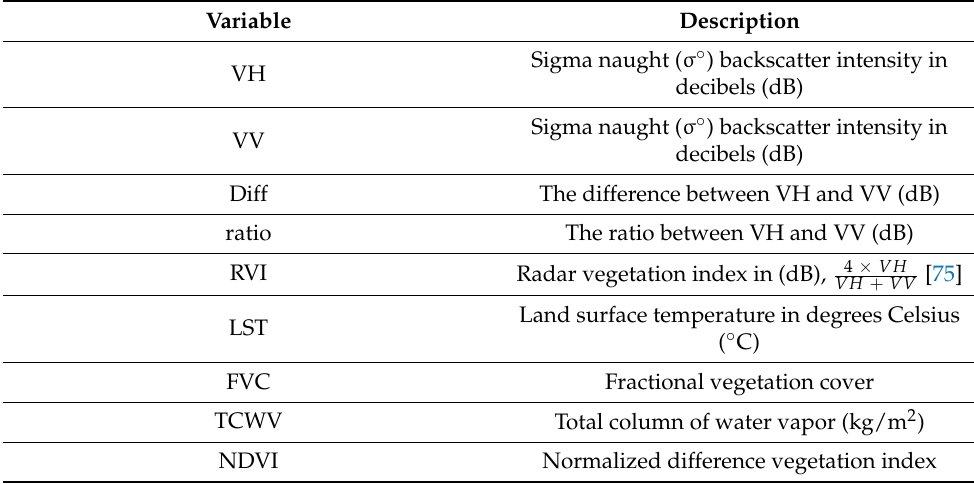
Table 1. Variables used in the study and their